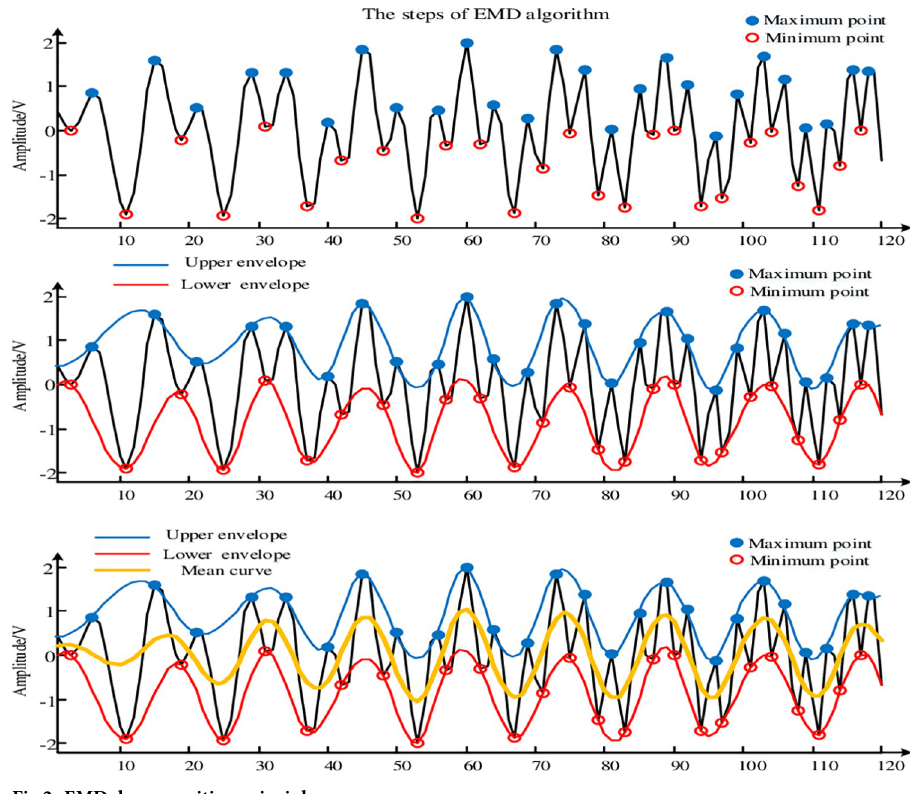
Fig 2. EMD decomposition